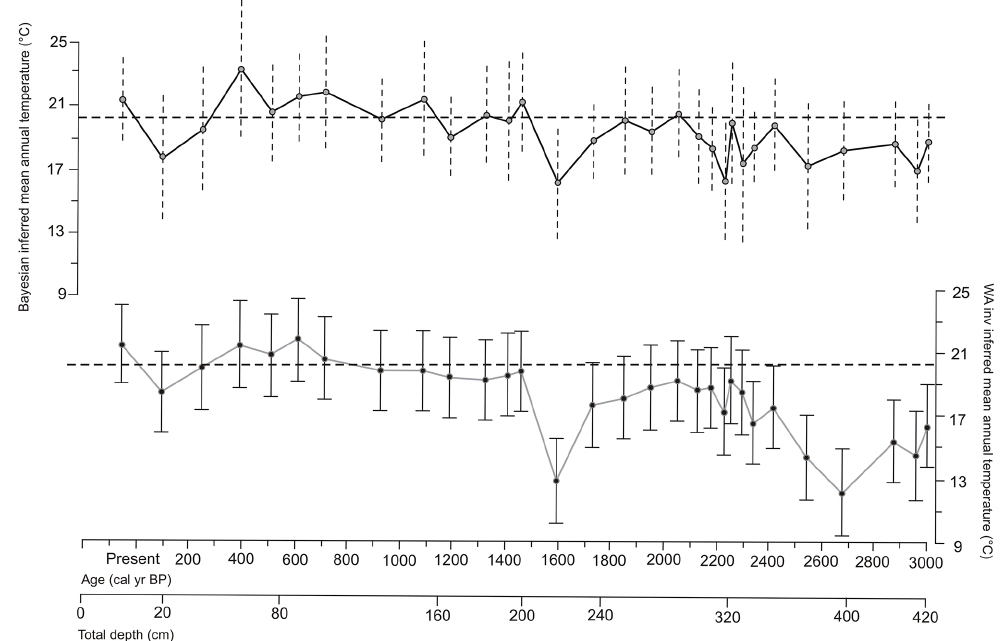
Figure 8. Chironomid-inferred mean annual temperatures (MAT) at Laguna Pindo using the WA inverse (grey) and Bayesian (black) models. Sample-specific errors for the WA model are obtained through bootstrapping 999 cycles. Errors in the Bayesian reconstruction are site- specific